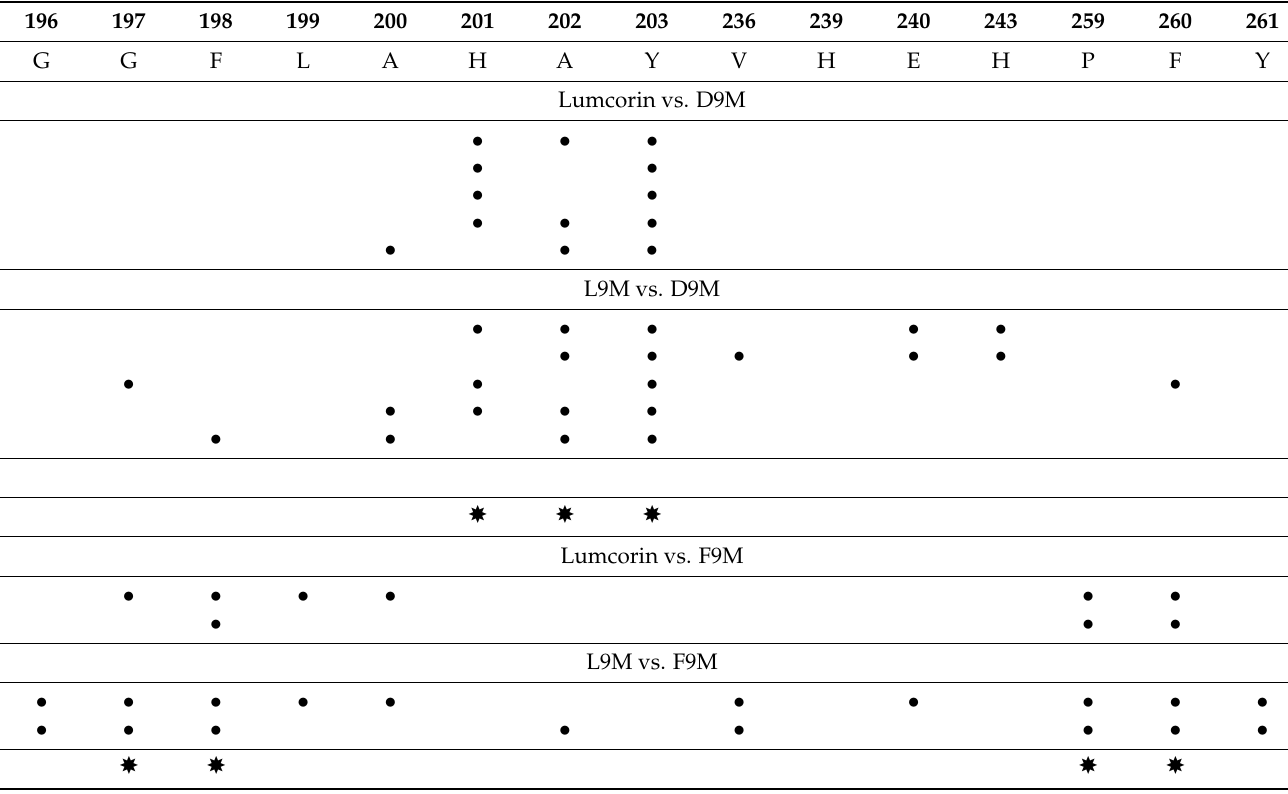
differences between the considered SLRP-derived peptide. Based on the comparison of the average number of contacts between peptides whose activity is known, key residues of the catalytic zone could be highlighted (panel G , violet surface), and docking solutions associated with L9Mc situated in the catalytic zone evidenced contacts involving some of these key residues (panel H ). Table 4. Summary of the training test.